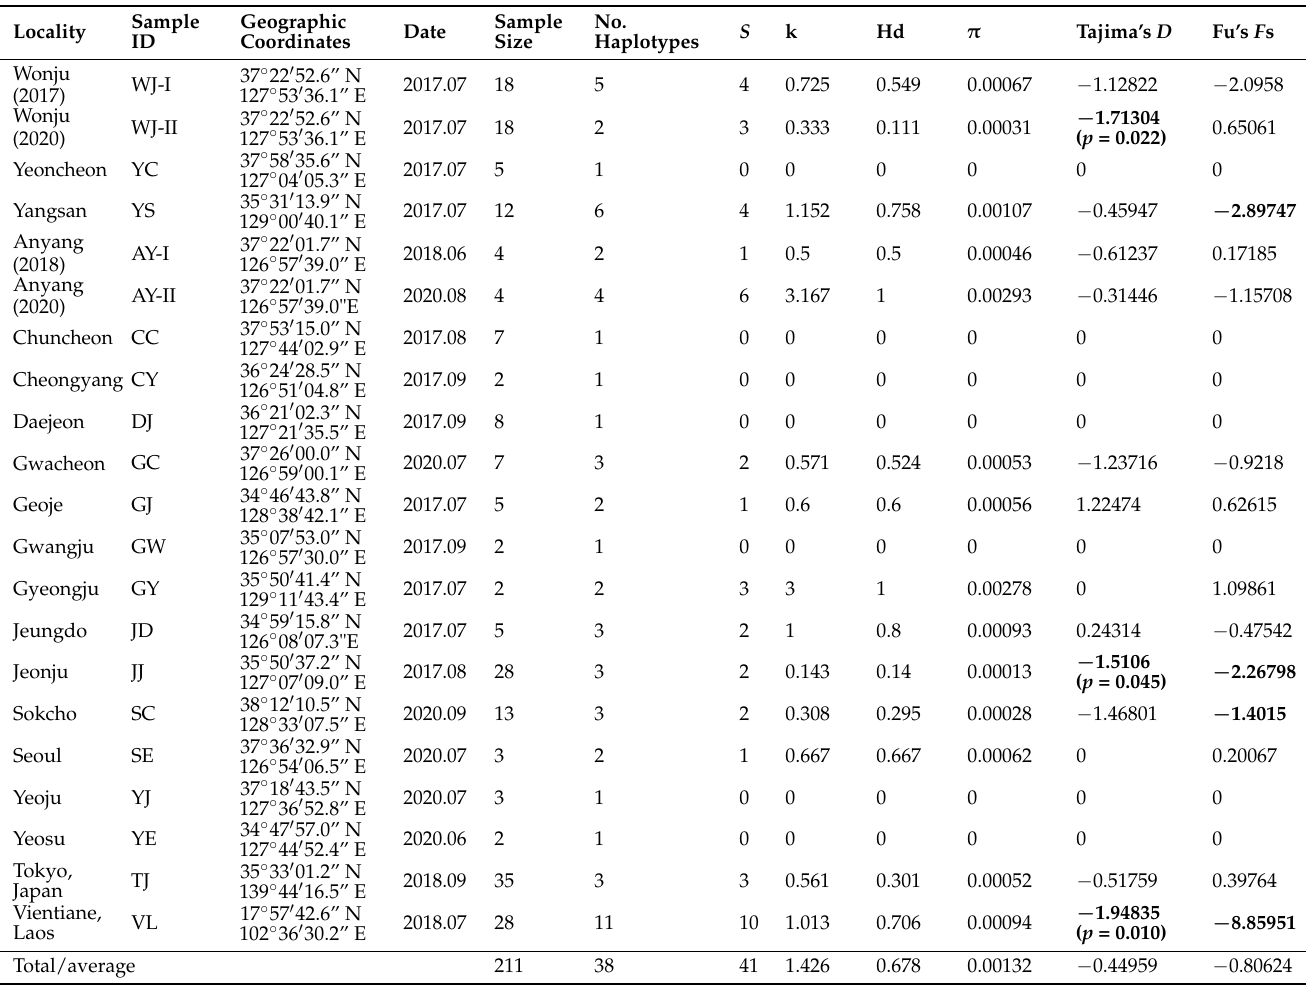
Table 1. Geographic information, haplotypes, and genetic analysis of the concatenated sequences of the mitochondrial DNA ( CO1 , ND5 ) from 21 different genetic populations of Aedes albopictus